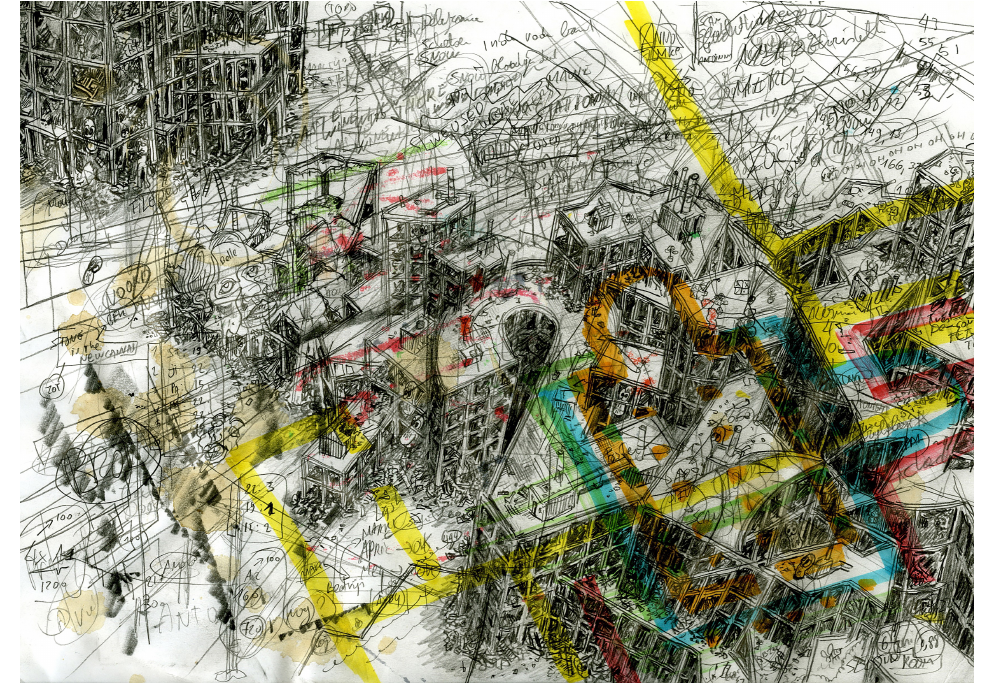
Figure 5: Andy’s memory is in